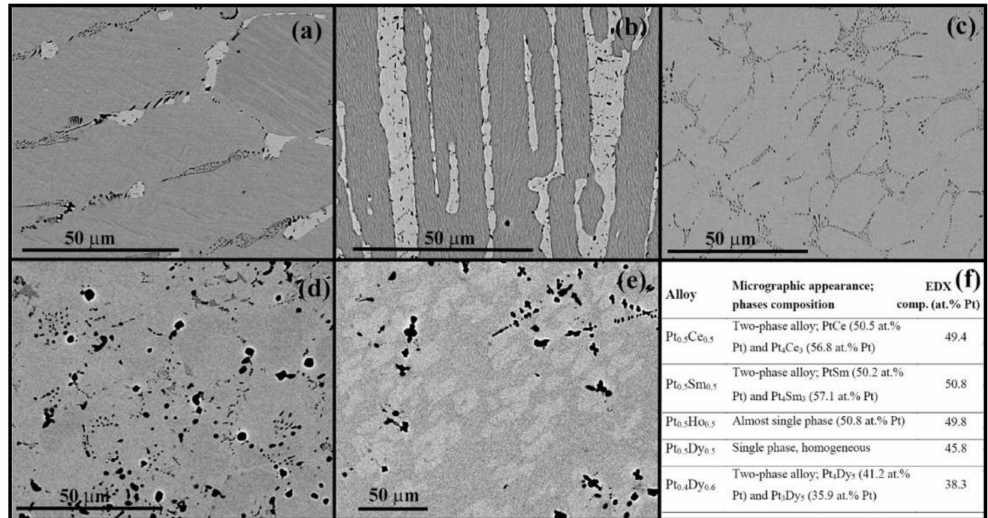
Figure 1. Micrographs (BSE image mode) obtained for ( a ) Pt 0.5 Ce 0.5 , ( b ) Pt 0.5 Sm 0.5 , ( c ) Pt 0.5 Ho 0.5 , ( d ) Pt 0.5 Dy 0.5 , and ( e ) Pt 0.4 Dy 0.6 , with ( f ) the corresponding energy dispersive X-ray analysis (EDS) results for each phase. Note: Pt = platinum.